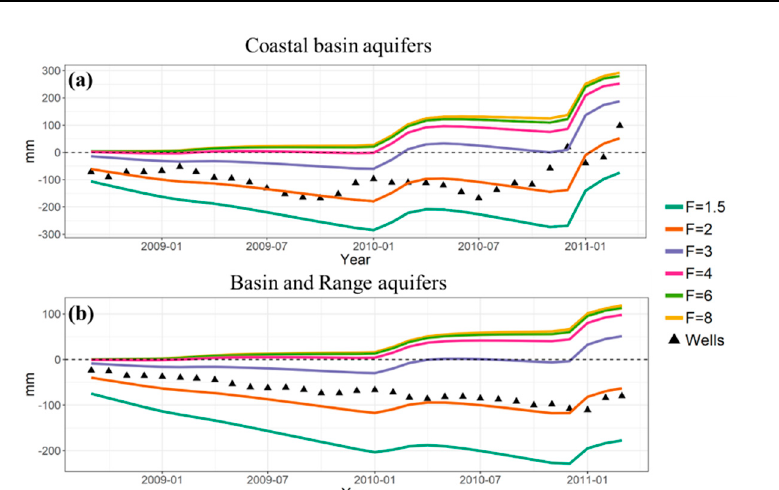
Figure 2. Average United States Geological Survey (USGS) well and simulated water table depth anomalies in the ( a ) Coastal Basin and ( b ) Basin and Range aquifer systems between October 2008 and March 2011 for baseflow decay factors ( F ) ranging from 1.5 to 8 m − 1 . Anomalies were calculated based on 2008–2011 average baseline. Well locations are listed in Table S1. Table 1. Impact of baseflow decay factor (m − 1 ) on the SSIB-SIMGM simulations for the two main aquifer systems in the study area. Statistics represent 4-year domain-average terrestrial water storage (TWS) anomaly bias (mm), root-mean squared error (RMSE) (mm), and temporal correlation (TCOR). * and ** indicates correlation significance at 90% and 99% confidence levels, respectively.